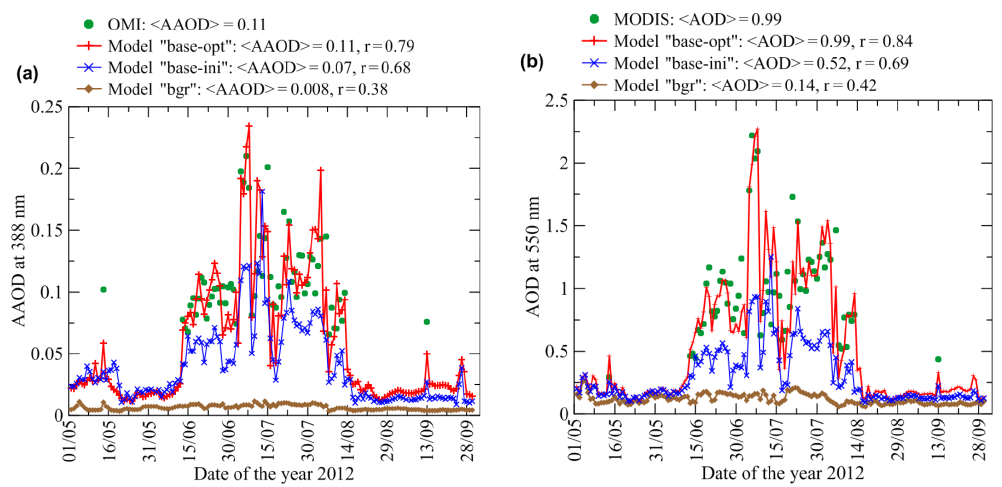
Figure 6. Time series of daily AAOD (a) and AOD (b) values averaged over the study region according to the OMI AAOD and MODIS AOD observations and simulations (“base-opt” and “base-ini”) performed with the optimized and initial-guess BB BC and OC emissions, as well as (“bgr”) without fire emissions. Note that whenever a sufficient number of the observational data points was available (see Sect. 3.2), the simulations were averaged over the same grid cells as the observations; otherwise, the simulated AAOD and AOD values were averaged over the whole study region. The numbers given in the figure legends report the mean AAOD and AOD values obtained by averaging over the observational data points and their simulated matchups shown in the figure as well as the values of the correlation coefficient.